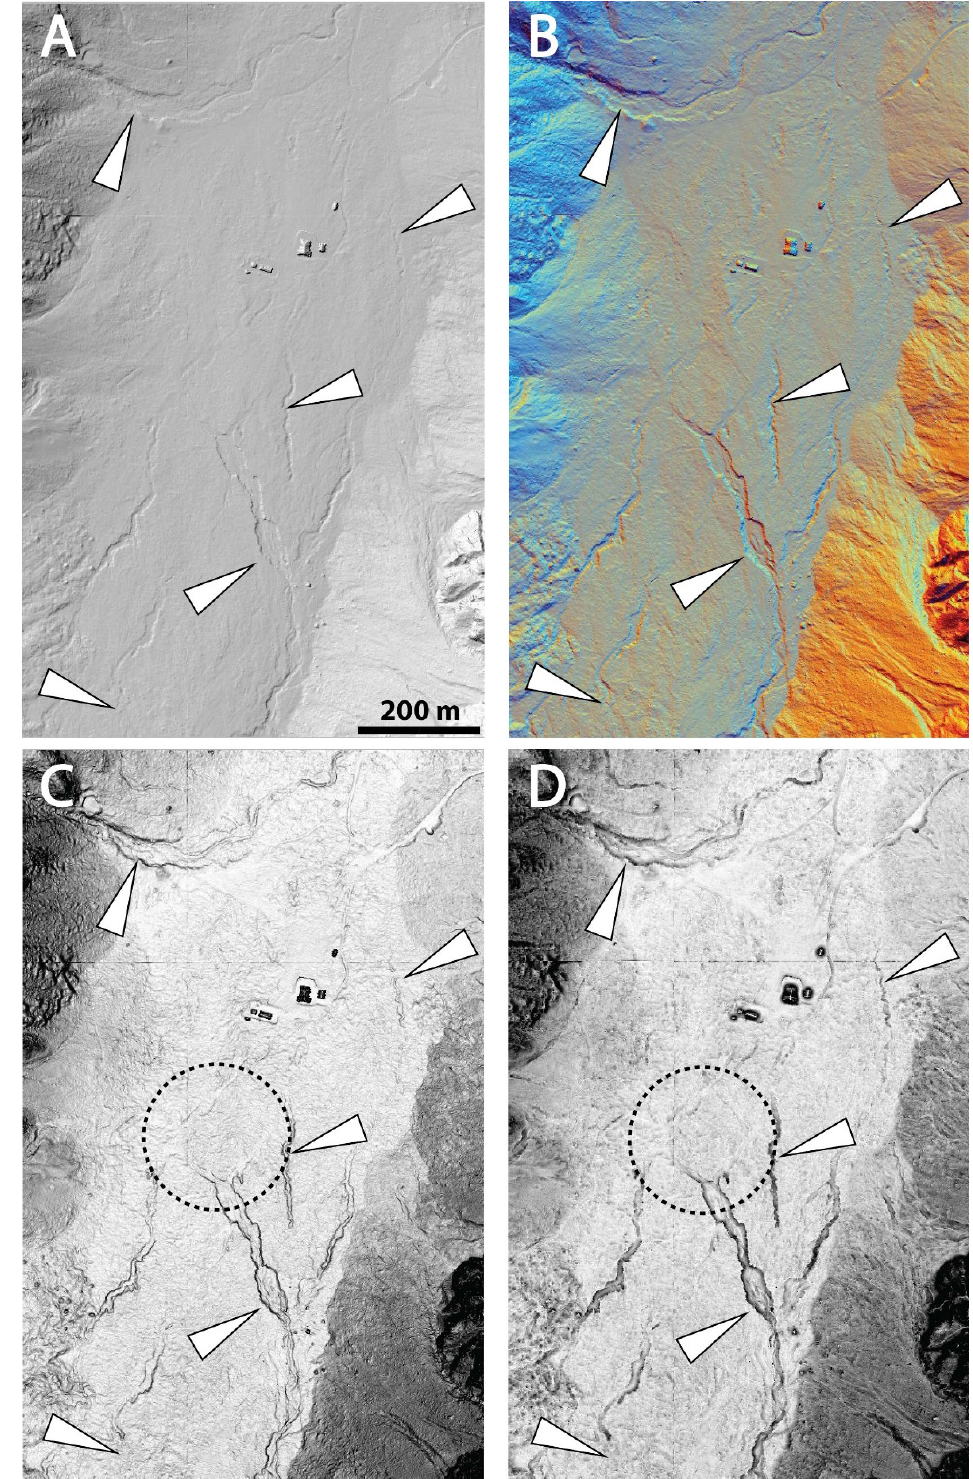
Figure 11. Torrential channels (marked with white arrows) incised into the fluvial deposit. The area of sediment deposited out of the channel is marked with a dashed circle. The rectangle features in the centre of images are a mountain hut and other buildings. ( A ) Analytical hillshading (A315, H35), ( B ) hillshading from multiple directions RGB (D16, H35), ( C ) 8-bit sky view factor, and ( D ) 8-bit slope visualisations. For location see rectangle 11 in Figure